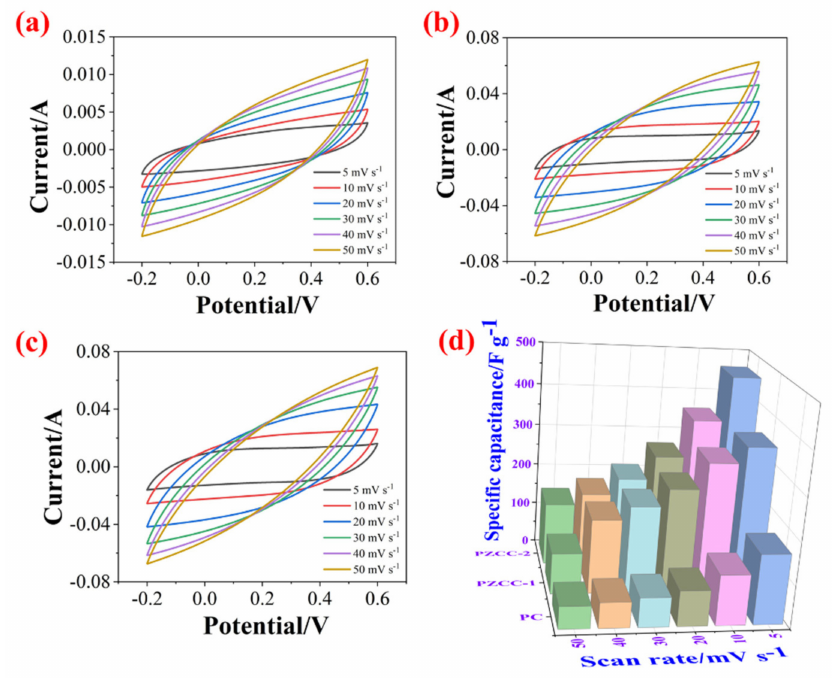
Figure 5. CV profiles of PC ( a ), PZCC-1 ( b ), and PZCC-2 ( c ) electrodes recorded using different scan rates of 5, 10, 20, 30, 40, and 50 mV · s − 1 , and ( d ) specific capacitance of PC, PZCC-1, and PZCC-2 at different densities of 5, 10, 20, 30, 40, and 50 mV · s − 1